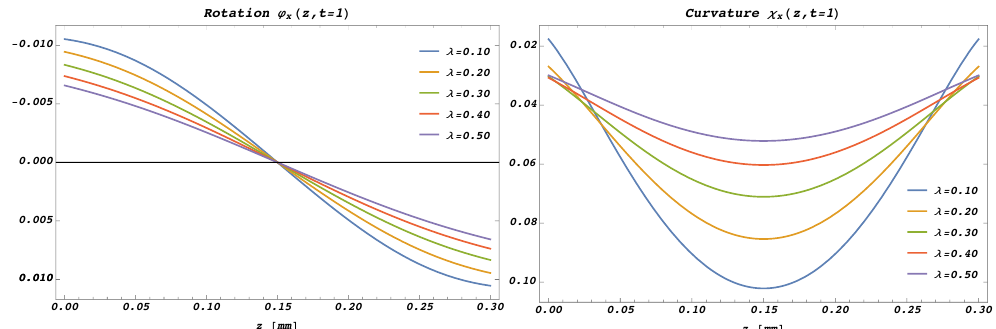
Figure 7. Rotation and curvature for different values of λ at t = 1